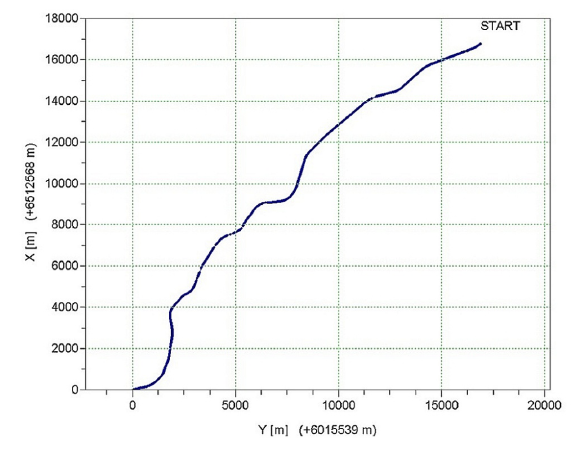
Figure 7: Example of visualization of the railway